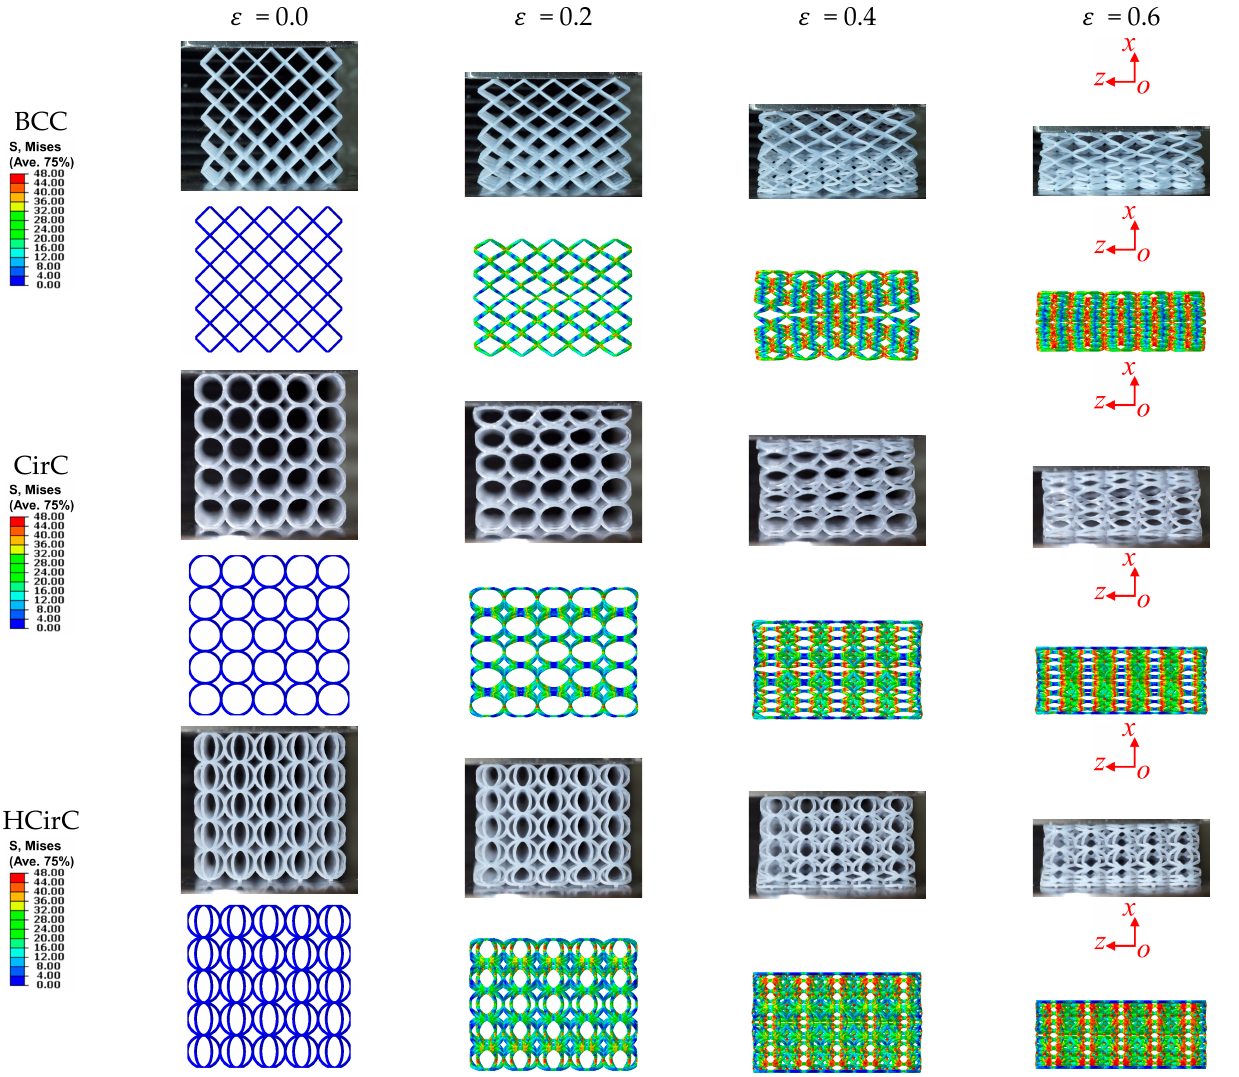
Figure 10. The compression behaviors of BCC, CirC, and HCirC (in XZ-views, and the compression direction is along the x -axis).